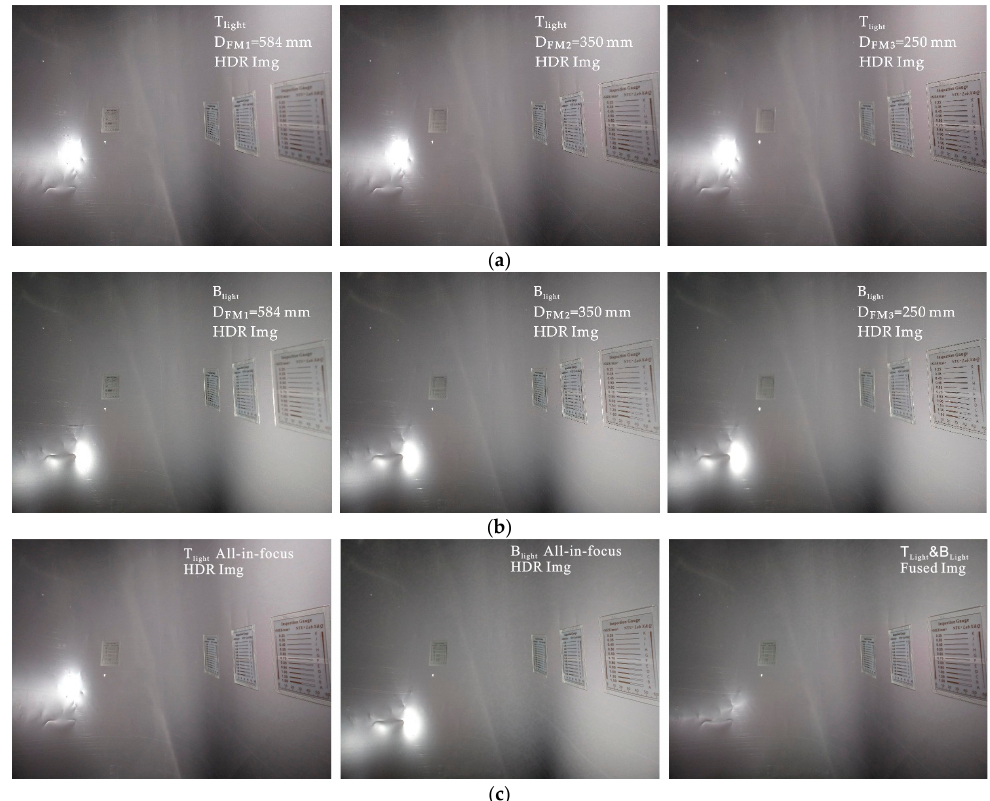
Figure 12. All-in-focus imaging with overexposure suppression under viewpoint iii: ( a ) three HDR images under T light with three depths of object plane, D FS1 = 584 mm, D FS2 = 350 mm, and D FS3 = 250 mm; ( b ) three HDR images under B light with three depths of object plane, D FS1 = 584 mm, D FS2 = 350 mm, D FS3 = 250 mm; ( c ) on the left is the all-in-focus HDR image which is obtained by fusing the three images under T light in Figure12a, in the middle is the all-in-focus HDR image which is obtained by fusing the three images under B light in Figure12b, and in the right is the the all-in-focus image without overexposure, which is obtained by fusing the left and the middle all-in-focus images.